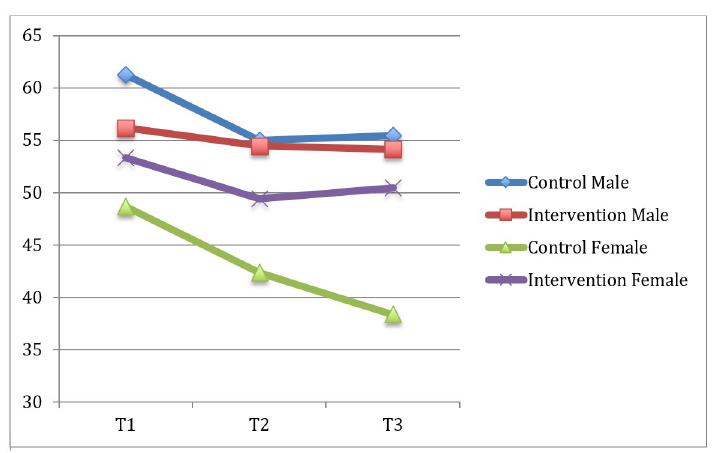
Fig 3. MVPA (minutes/day) across time and gender for control and intervention